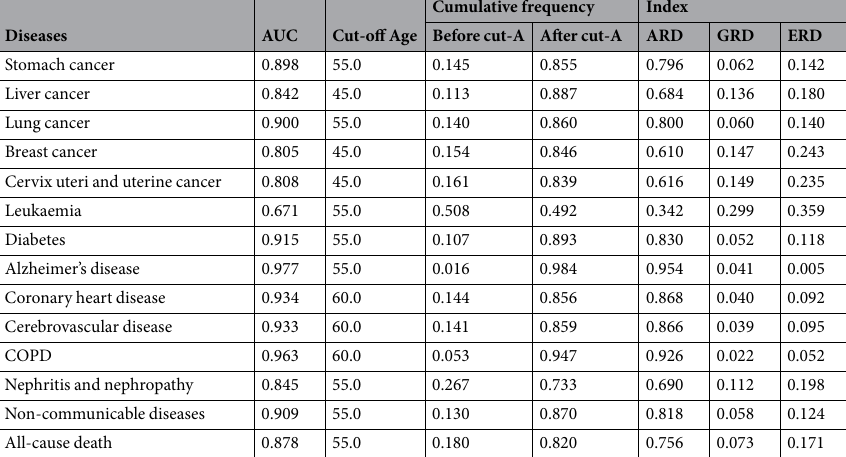
Table 3. Raw data and indices for ageing, genetic, and exogenous role in death caused by chronic diseases. ARD, GRD and ERD represent the indices for ageing, genetic, and exogenous roles in death, respectively; AUC represents the area under the curve from ROC analysis; AUC: area under the curve; cut-A: cut-off age; COPD: chronic obstructive pulmonary